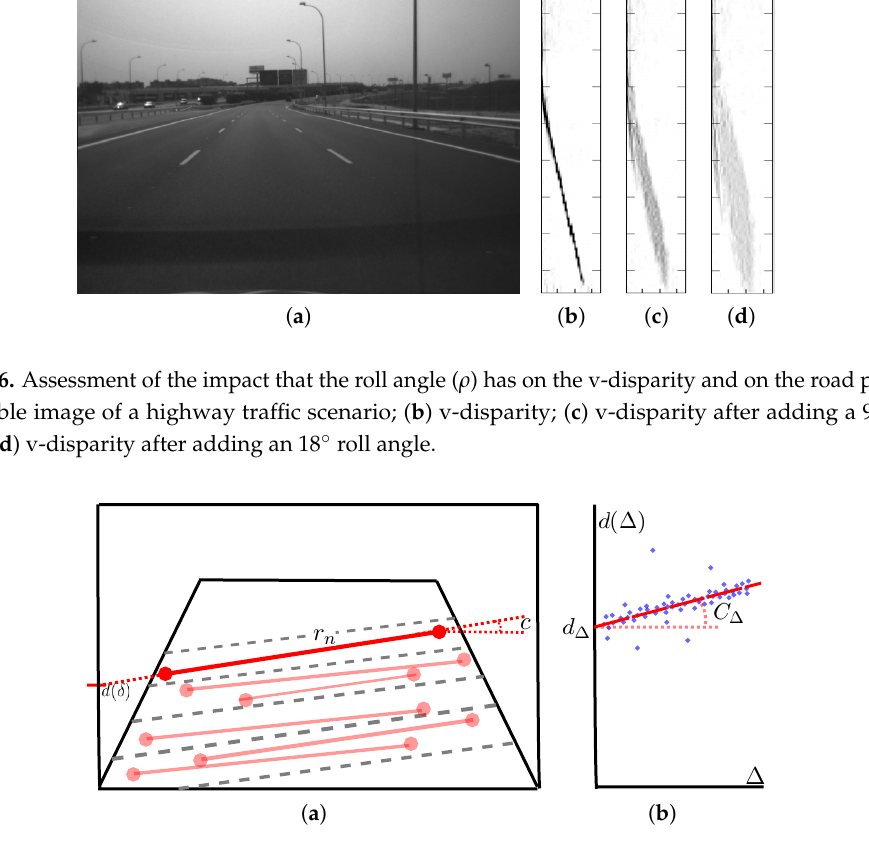
Figure 7. Schema of the different stages of the self-calibration method of the extrinsic parameters ( h , θ , ρ ) when the roll angle ( ρ ) has non-negligible values. ( a ) Schema of the first stage of the method, which shows the straight lines (lines in red) that join the points (points in red) belonging to the road in the free map for each level of disparity; ( b ) schema of the second stage, which depicts how to fit the linear equation (dashed line in red) resulting from the point cloud data { d ( δ ) } n (points in